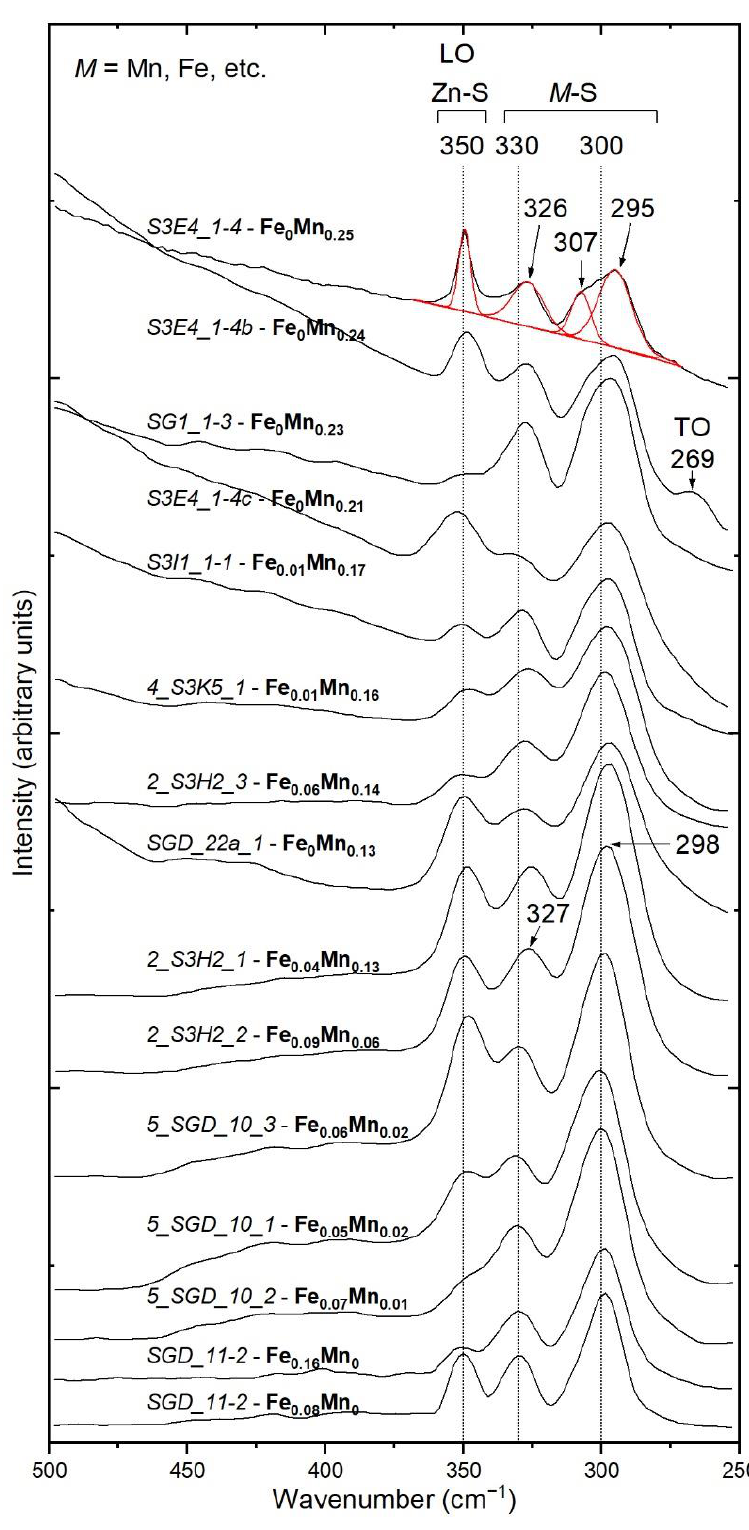
Figure 4. Raman spectra of the natural sphalerite samples from the Săcărâmb ore deposit. The spectra are displaced vertically for clarity. The red line represents the deconvolution with Gaussian fitting for sample S3E4_1-4 with 𝑥 𝑀𝑛 = 0.25 .